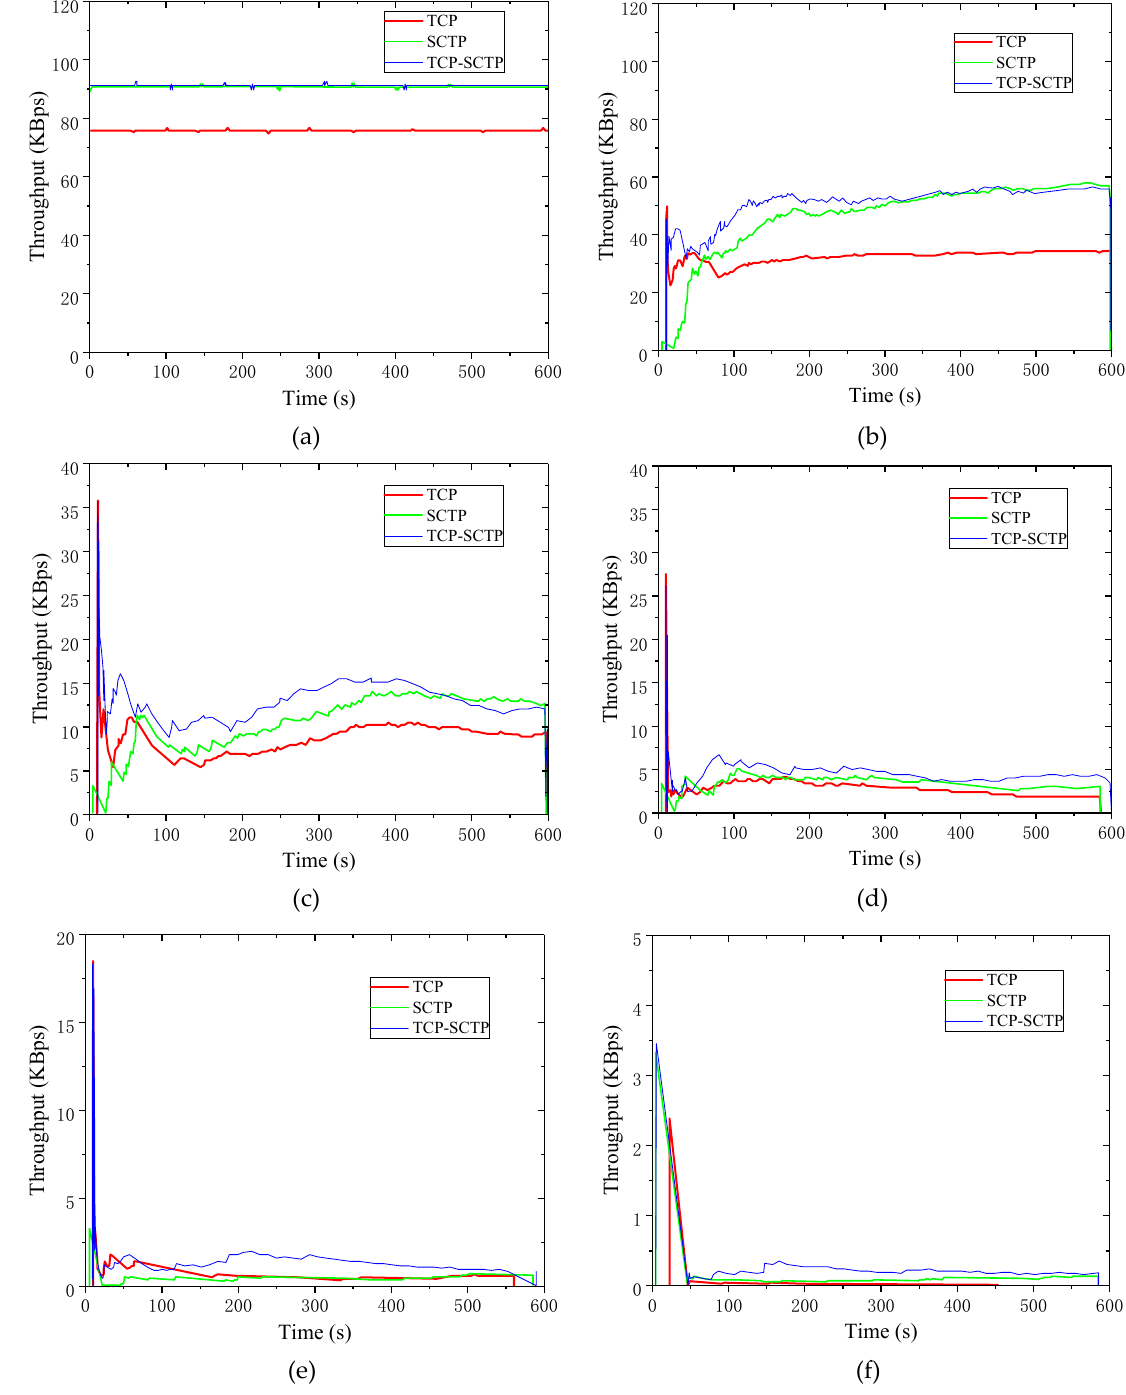
Figure 9. Real-time throughput compare when the error rate was 0–50%. ( a ) PER: 0%; ( b ) PER: 10%; ( c ) PER: 20%; ( d ) PER: 30%; ( e ) PER: 40%; ( f ) PER: 50%.